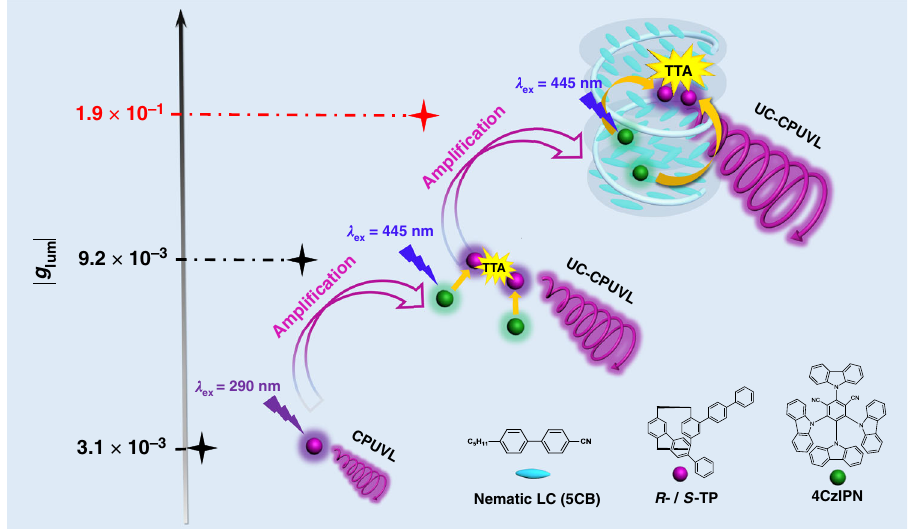
Fig. 1 The process of sequentially ampli fi ed CPUVL. Chemical structures of R -/ S -TP, 4CzIPN, 5CB and schematic representation of sequentially ampli fi ed CPUVL. R ( S )-TP showed a weak CPUVL emission (| g lum | = 3.1 × 10 − 3 ) in toluene solution when excited by the 290 nm. After embedding with achiral sensitizer 4CzIPN, UC-CPUVL could be observed under the excitation of 445 nm continuous wave laser (A 445 nm short-pass fi lter was used). Due to the ampli fi cation effect photon upconversion on CPUVL emission, the g lum value of UC-CPUVL reached to 9.2 × 10 − 3 and showed three times larger than the downconversion process. Subsequently, chiral emitter and TADF sensitizer were adopted into the nematic liquid crystal (5CB), induced N*LC performed enhanced UC-CPUVL with a larger g lum value (| g lum | = 1.9 × 10 − 1 ), which could trigger the enantioselective polymerization of diacetylene with good